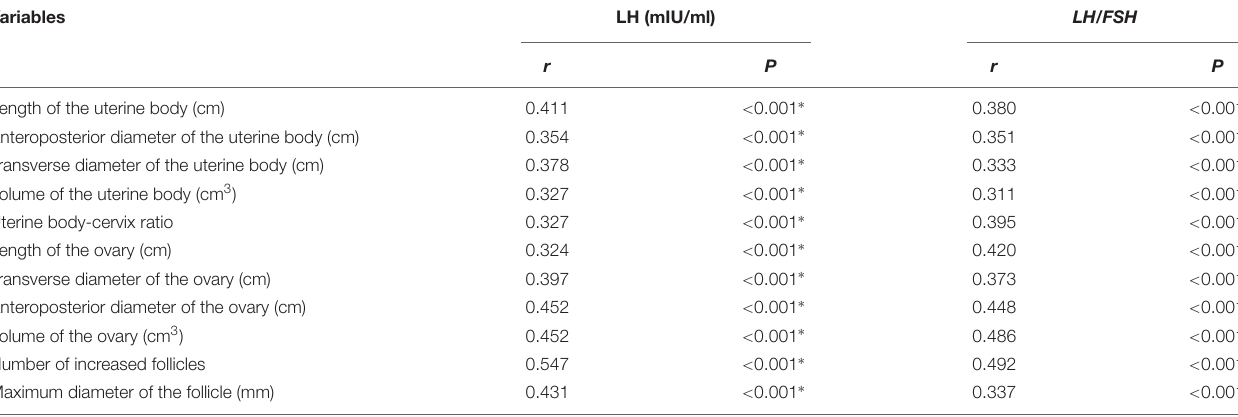
FIGURE 2 | The receiver-operating characteristic curve for the pelvic ultrasound parameters to distinguish between patients with ICPP and controls. (A) uterine parameters, (B) ovary parameters. TABLE 4 | Correlation of the pelvic ultrasound parameters with serum sexual hormone levels in ICPP group before and after GnRHa therapy. Variables LH